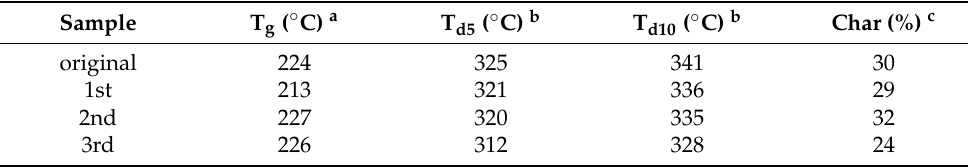
Figure 7. The DMA curves of original and reprocessed OBZ-BDB.